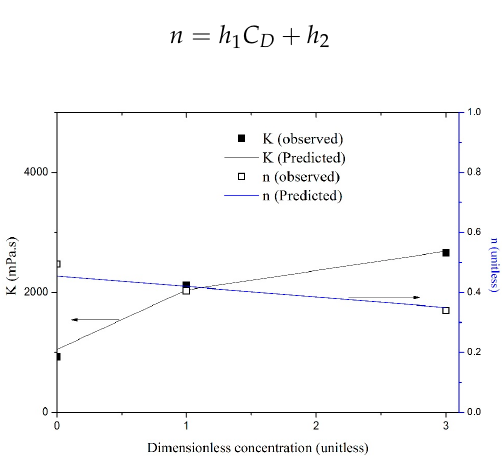
Figure 4. Effect of pressure on power-law parameters K and n on CO 2 Foam.